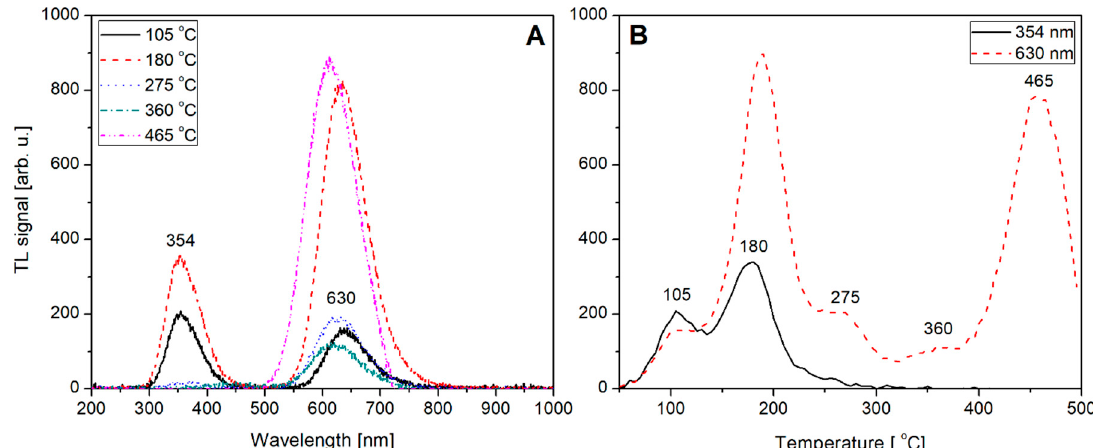
Figure 9. Thermoluminescence (TL) emission spectra (panel A ) measured for the undoped LiMgPO 4 crystal at different temperatures corresponding to the glow-peaks maxima. TL glow-curves (panel B ) measured for the undoped LiMgPO 4 crystal (irradiated with beta radiation) at different wavelengths corresponding to emission maxima.